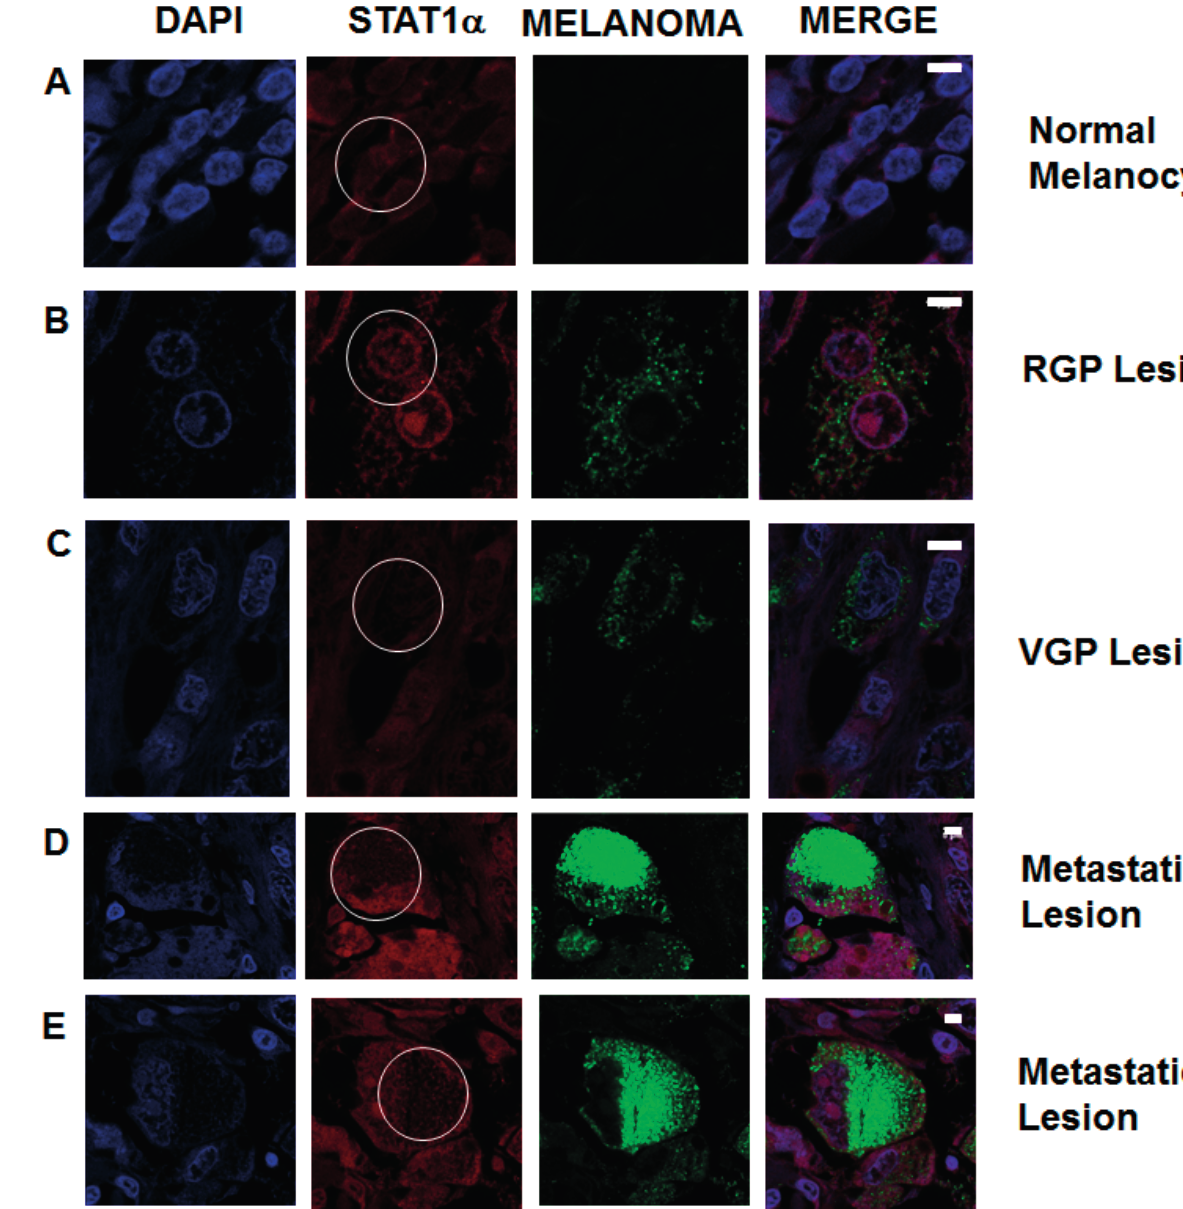
Figure 7. Immunofluorescence staining of STAT1 expression in non-metastatic and metastatic melanocytic lesions from patient samples. Tissue microarrays of patient samples were de-waxed, rehydrated and stained for the expression of STAT1 (red) and metastatic melanoma biomarkers (green). Cell nuclei are stained with DAPI (blue). Regions of interest are circled in white on the STAT1 panels. ( A ) Normal melanocytes show constitutive STAT1 expression; ( B ) Primary tumors characterized as RGP show a slight decrease in STAT1 expression; ( C ) VGP melanoma lesions show an increase in melanoma biomarkers, as well as a decrease in STAT1; ( D , E ) Metastatic melanoma lesions show a marked increase in metastatic melanoma biomarkers, which correlates with a decrease in STAT1. These data show a correlation between biomarkers of metastasis and the decrease in STAT1 expression in patient tumor samples. Data are representative of images taken from approximately 150 patient samples. Scale bars represent 5